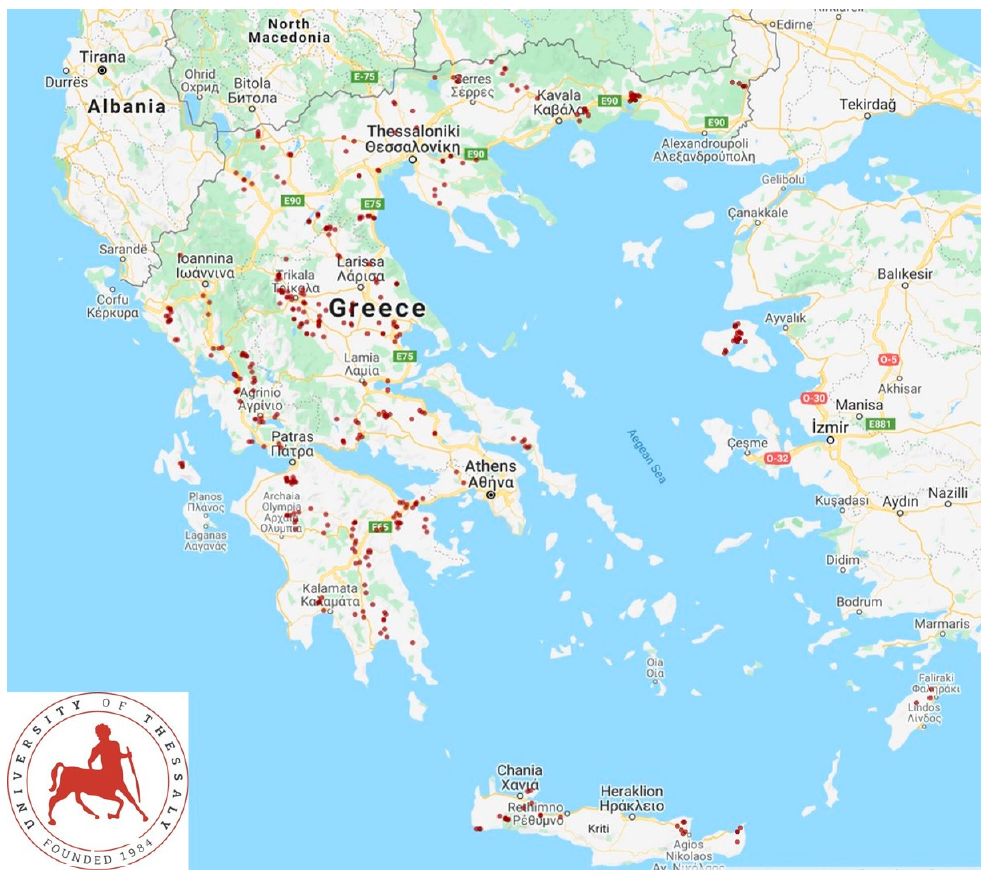
Figure 1. Location of 444 sheep flocks/goat herds around Greece, in which interviews were